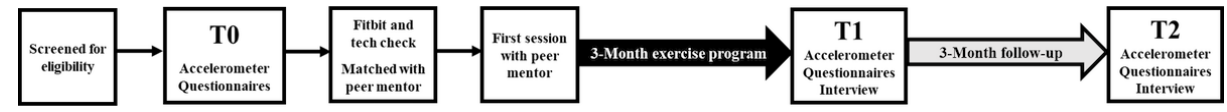
Figure 1. Flow diagram of the Pink Body Spirit pilot